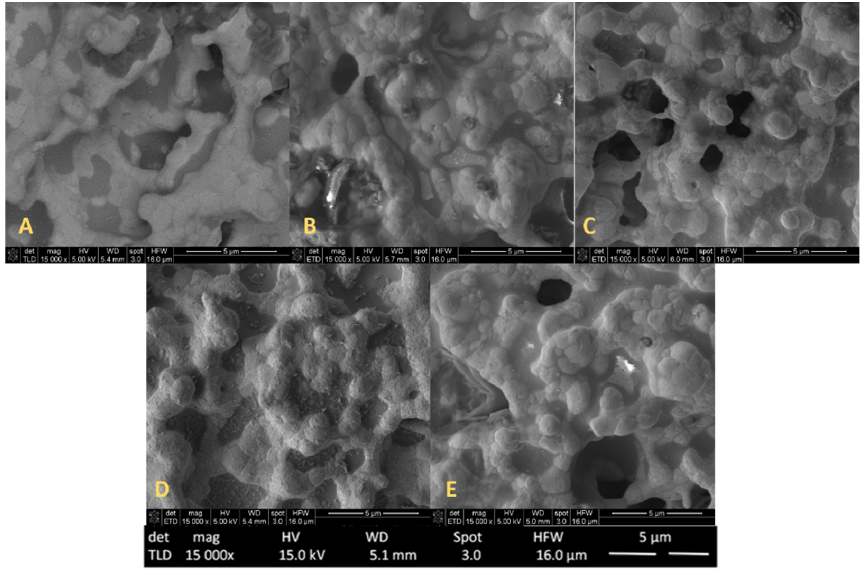
Figure 12. SEM images of platinum working electrode after each cleaning method: ( A ) untreated; ( B ) acetone; ( C ) ethyl alcohol; ( D ) H 2 O 2 ; ( E ) electrochemical.